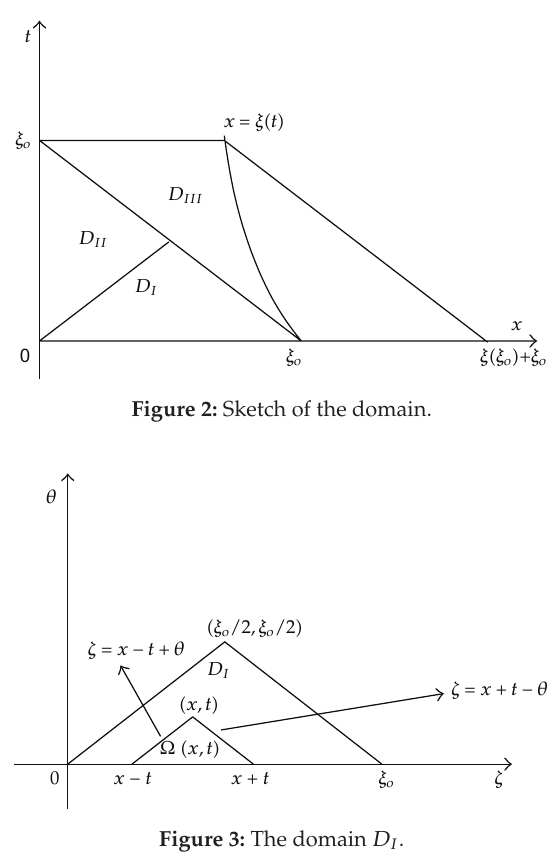
Figure 2: Sketch of the domain.